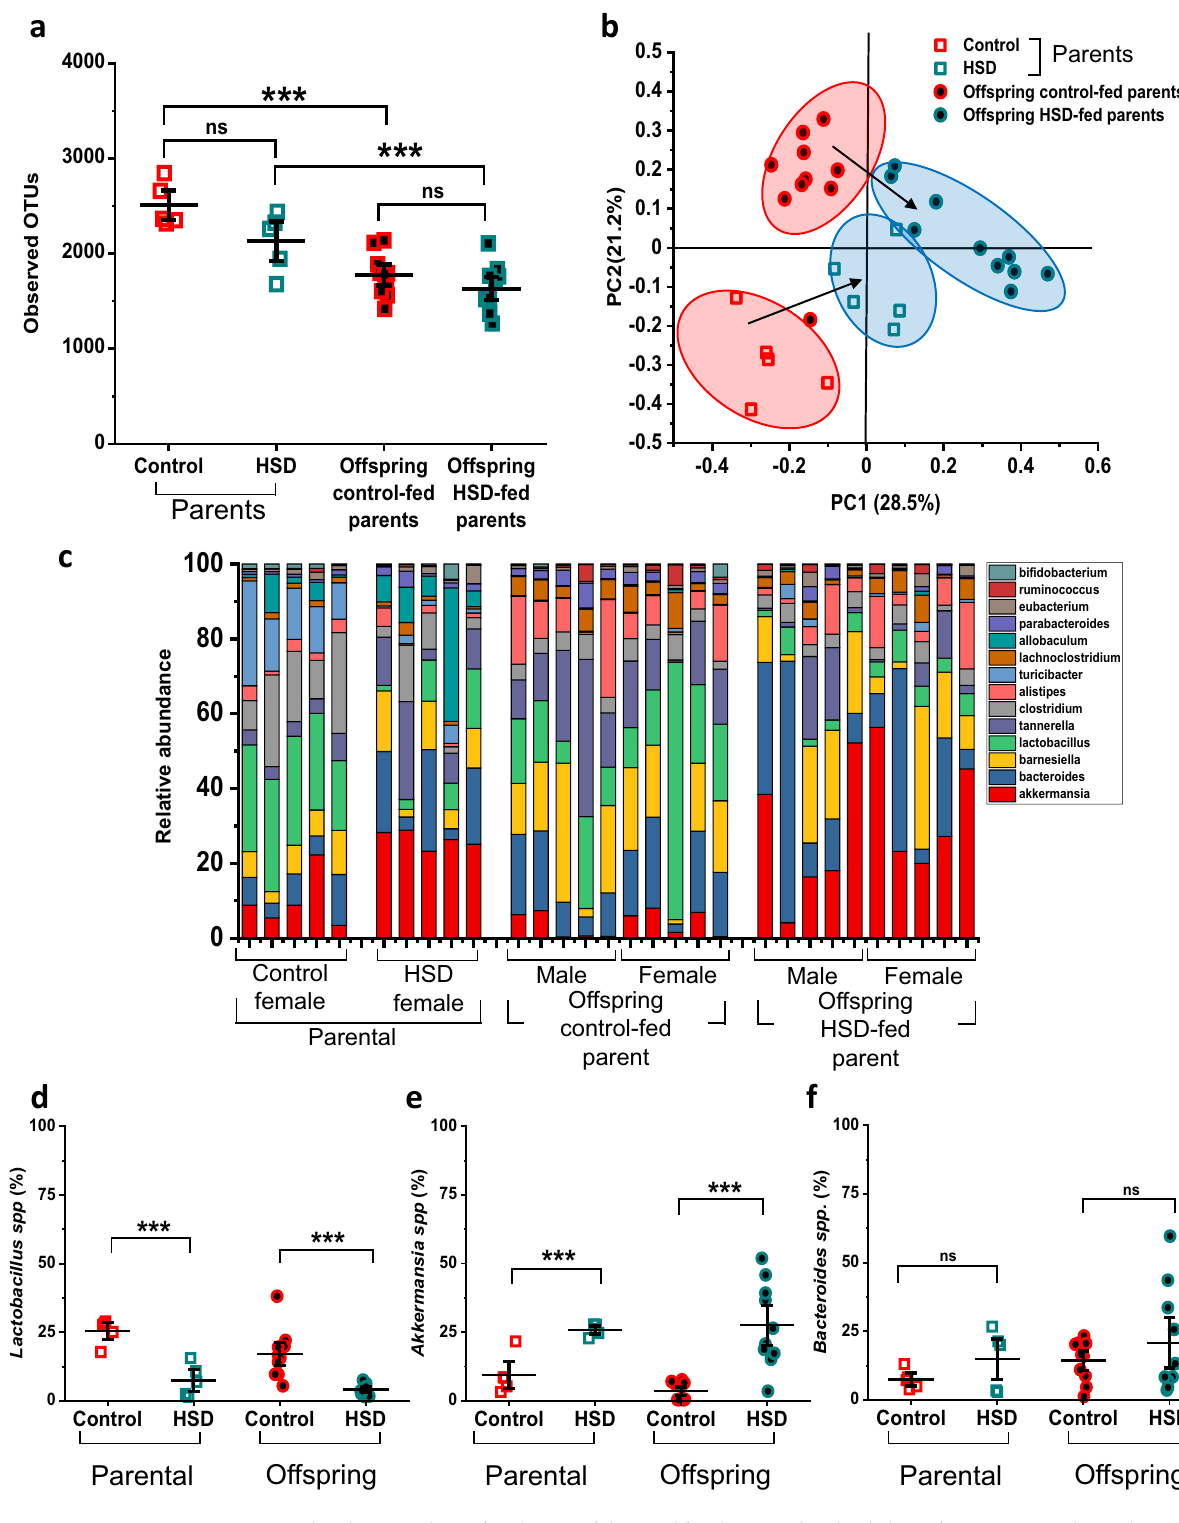
Figure 3. Altered gut microbiome found in HSD-fed parental female mice is shared with their offspring. Gut microbiome data was obtained from fecal samples and analyzed from 16 s rRNA sequencing. ( a ) No difference was found in observed OTUs between control and HSD-fed dams as well as between their respective offspring (n = 5 control-fed dam, 5 HSD-fed dam, 10 mice from control-fed parent, 10 from HSD-fed parent). ( b ) Principal coordinate analysis (PCoA) plots of Bray–Curtis distance metrics show separate clustering of microbiome from parental and offspring generation. Black arrows indicate the direction of significant shift in microbiota composition between groups. ( c ) Summary of relative abundance of the top 14 most abundant microbial genera in the community sampled. Topmost abundant genera, Lactobacillus spp was significantly reduced, Akkermansia spp was increased and Bacteroides spp was unchanged in HSD-fed dams as well as in their offspring ( d , e , f ). Data are described as the mean ± SEM. * p < 0.05, ** p < 0.01, *** p < 0.001, one-way ANOVA and Tukey’s